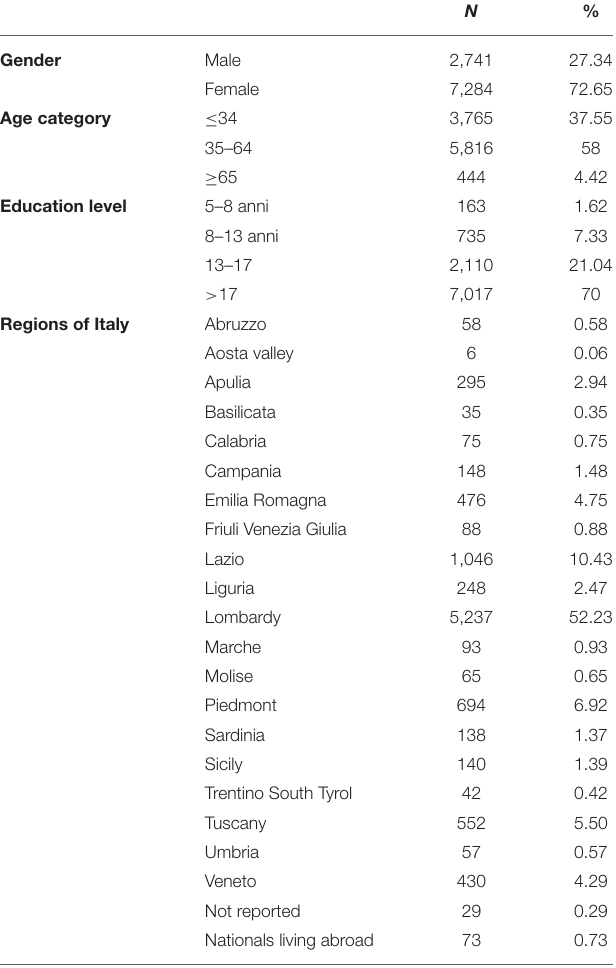
TABLE 1 | Demographic characteristics of the